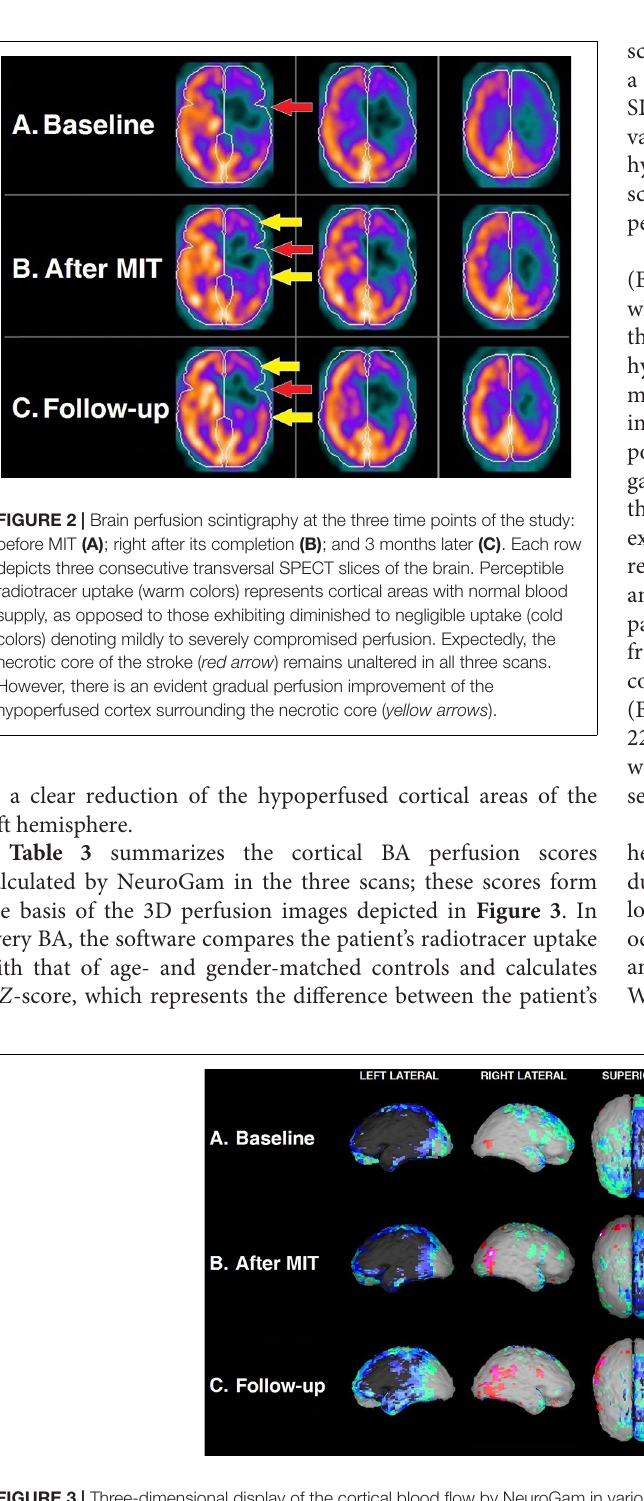
FIGURE 3 | Three-dimensional display of the cortical blood flow by NeuroGam in various views at the three time points of the study: before MIT (A) ; right after its completion (B) ; and 3 months later (C) . Cortical perfusion is depicted as the difference between the patient’s perfusion score and the mean score of age- and gender-matched reference controls and is expressed as a fraction of the control’s SD value (henceforth referred to as Z -score). Cortical areas with scores laying in the range between –1.99 SD and +1,99 SD (i.e., regions imaged in light gray) are considered normal to marginally hypo- or hyperperfused, respectively, hence the software does not assign to these any particular color coding. Those areas that exhibit significant to severe hypoperfusion ( Z -scores from –2.0 SD to –5.0 SD) are color-coded cold (green, light blue, dark blue, and dark gray), while the substantially hyperperfused ones ( Z -scores from +2.0 SD to +5.0 SD) are color-coded warm (red, magenta, and